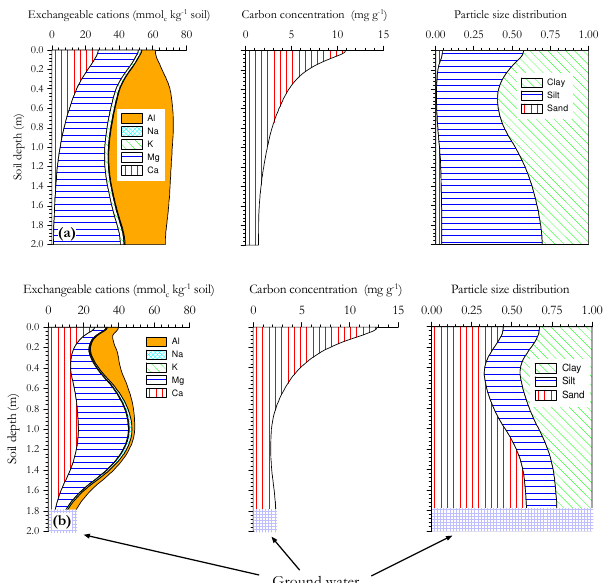
Fig. 10 Fig. 10. Profiles of exchangeable cations, soil carbon and tex- ture: (a) for a Haplic Alisol (Hyperdystric, Siltic) in south Peru (TAM -06) and (a) for a Hyperalic Alisol (Hyperdystric, Clayic) in Ecuador